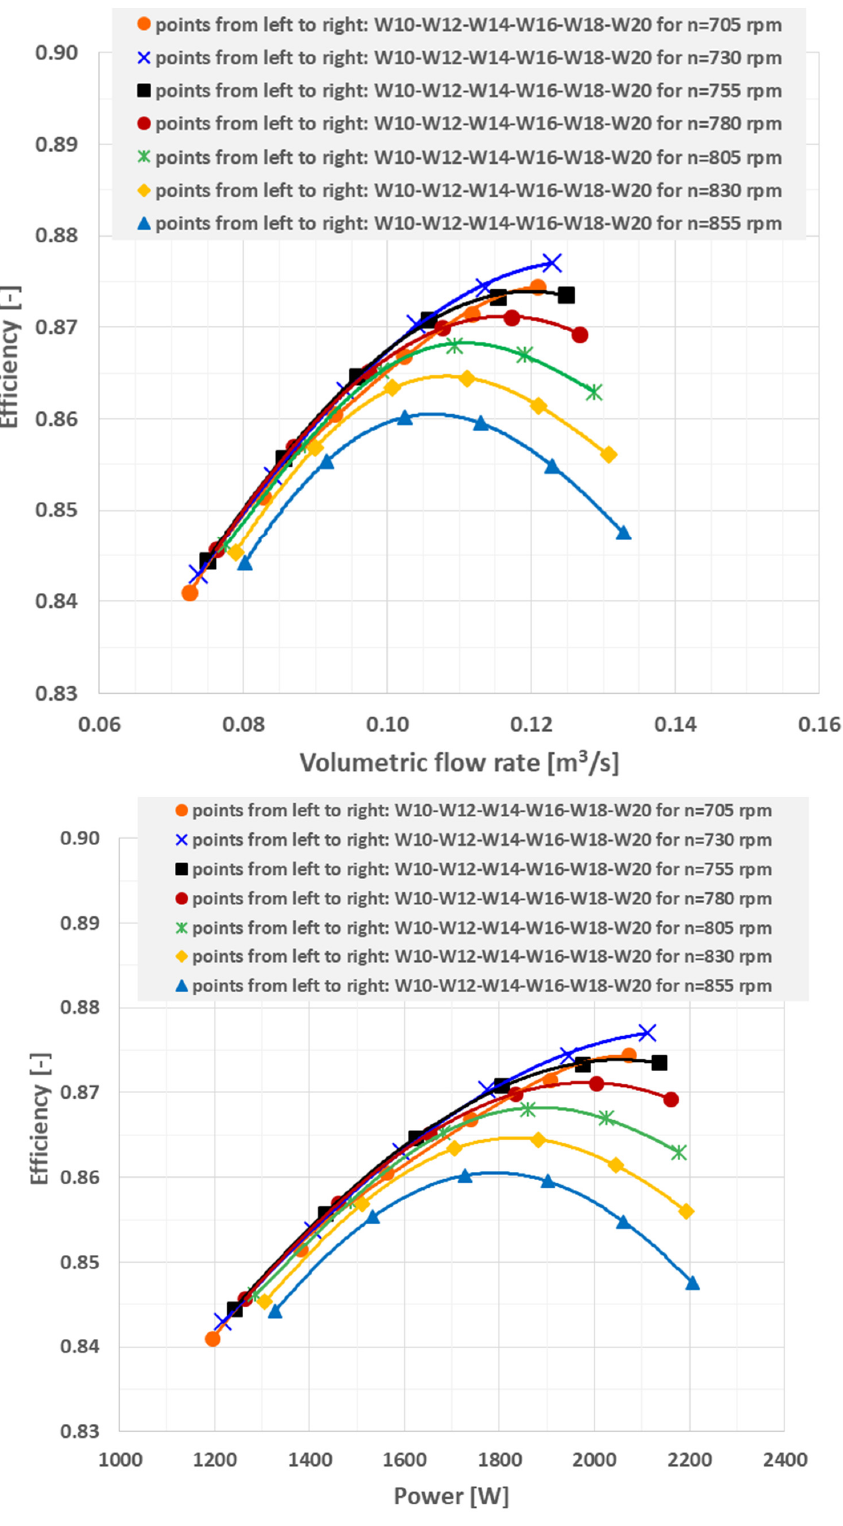
Figure 8. Efficiency curves vs. flow rate and power for semi-Kaplan turbine with 4-blade runner.